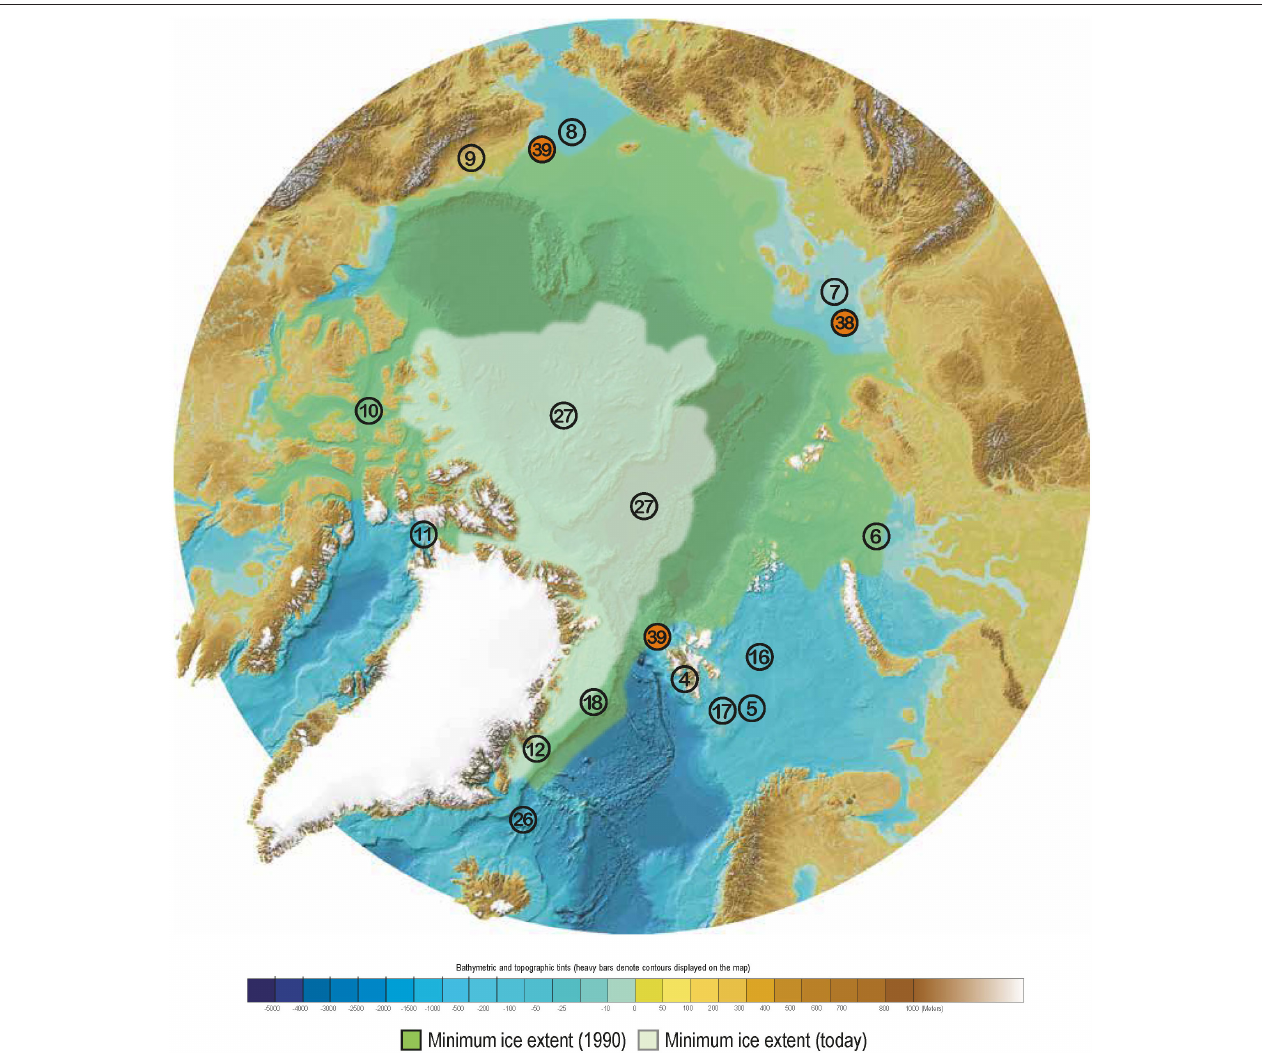
FIGURE 1 | Geographic distribution of pan-Arctic integration publications, i.e., pan-Arctic publications that address the ecological function of entire ecosystems. See Supplement 1 for a numbered overview of all pan-Arctic integration publications. The colored circles indicate the publications from the present